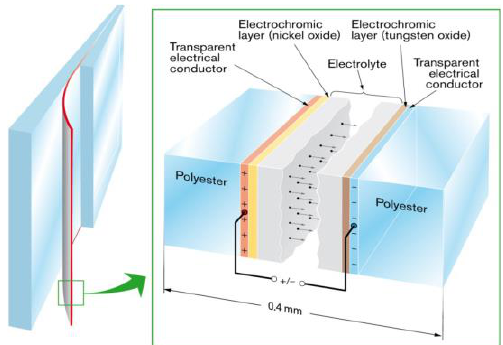
Figure 3. Principle design of an EC device fabricated in the form of a foil to be used for glass lamination, as indicated in the left-hand part. Reprinted from “Electrochromics on a roll: Web-coating and lamination for smart windows”, Surface & Coatings Technology 336 (2018) 133–138, Copyright (2018), with permission from Elsevier.